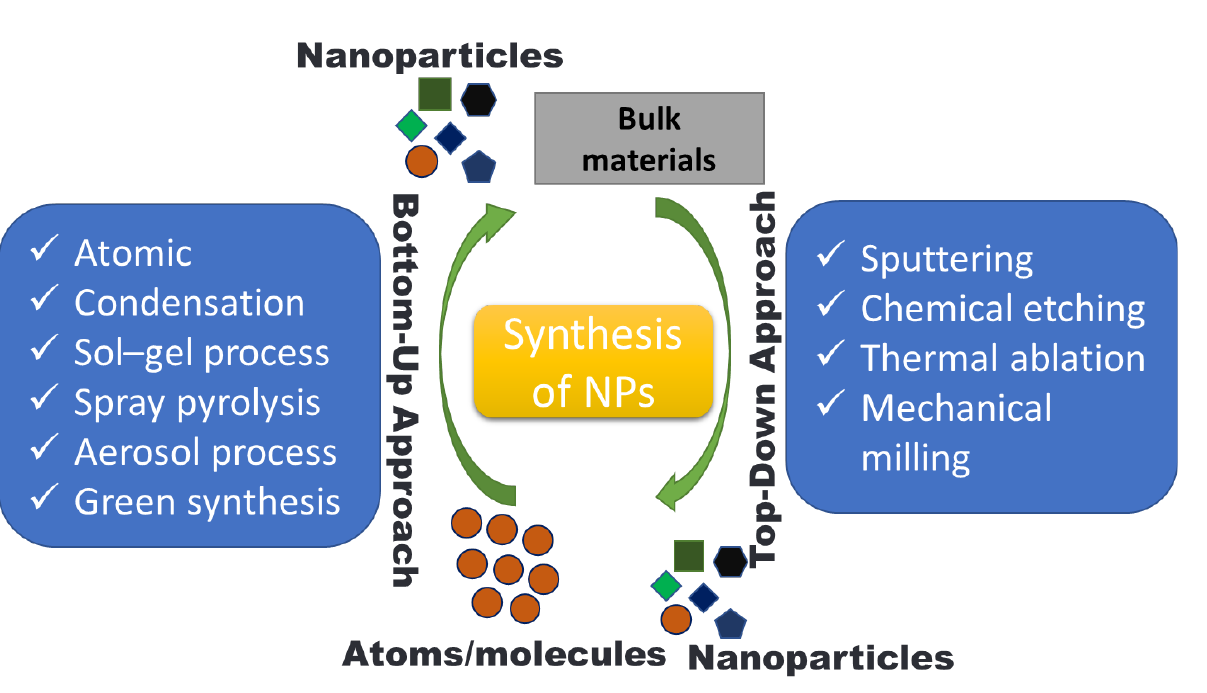
Figure 3. Nanoparticle synthesis strategies.